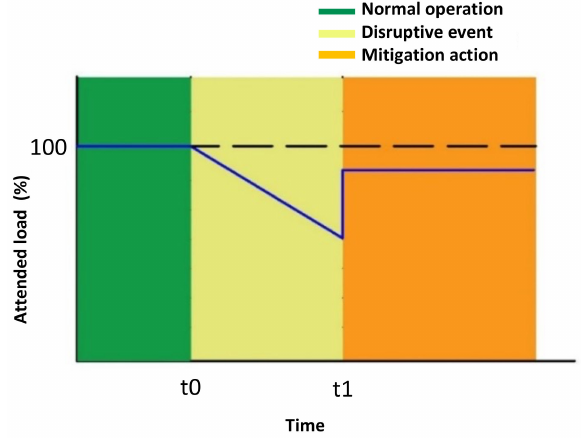
Figure 2. Resilience assessment